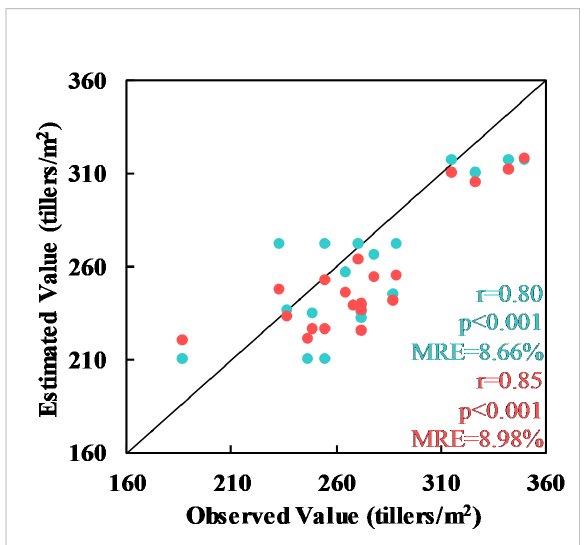
FIGURE 10 Comparison of the tiller density estimates at Xiaotangshan (cyan) and in the Xiongan study area (red) with another validation